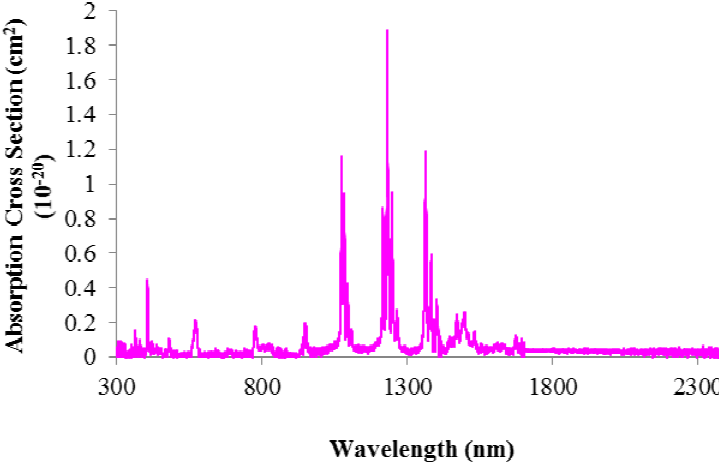
Figure 39. Absorption cross-section as a function of wavelength for a hydrothermally-grown Sm 3+ :LuAG crystal at 298 K.